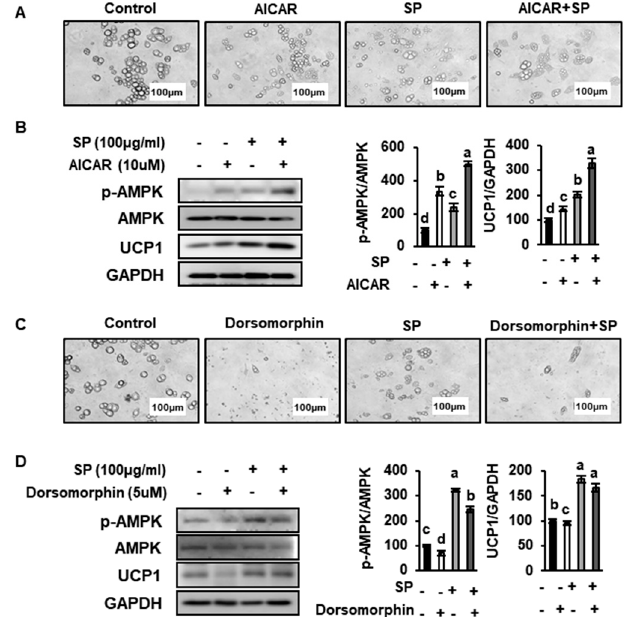
Figure 10. E ff ects of AMPK on lipid droplet morphology and the expression of UCP1 in primary cultures of subcutaneous white adipocytes. ( A , C ) Morphology was evaluated by optical microscopy at 400 × magnification. Scale bar: 100 mM. ( B , D ) Primary cells were treated with 10 µ M AICAR or 5 µ M dorsomorphin, and the e ff ects on protein expression were determined using western blotting. Data are expressed as mean ± SD ( n = 4). Values with di ff erent letters were significantly di ff erent; p < 0.05 (a > b > c >